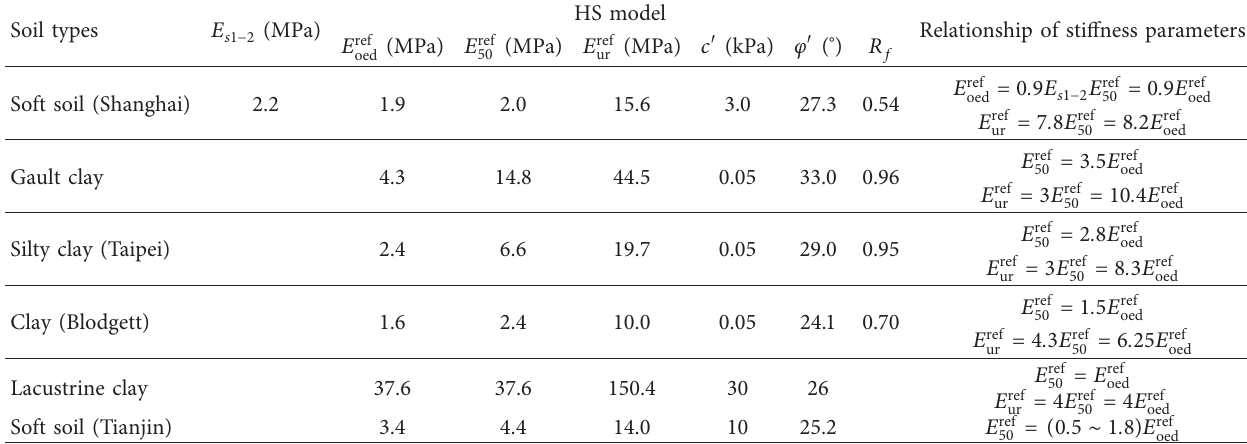
Table 6: Comparisons of parameters of soil and cemented clay of the HS model [2,